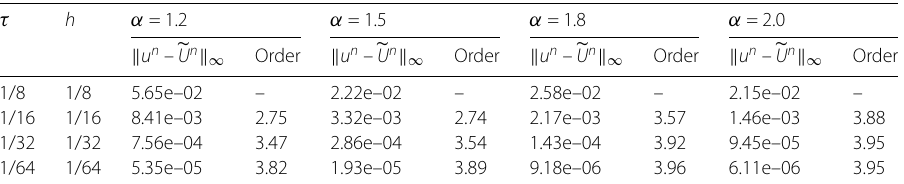
Table 3 L ∞ -norm errors and convergence orders of (cid:24) U obtained by the fourth-order scheme for Example 2